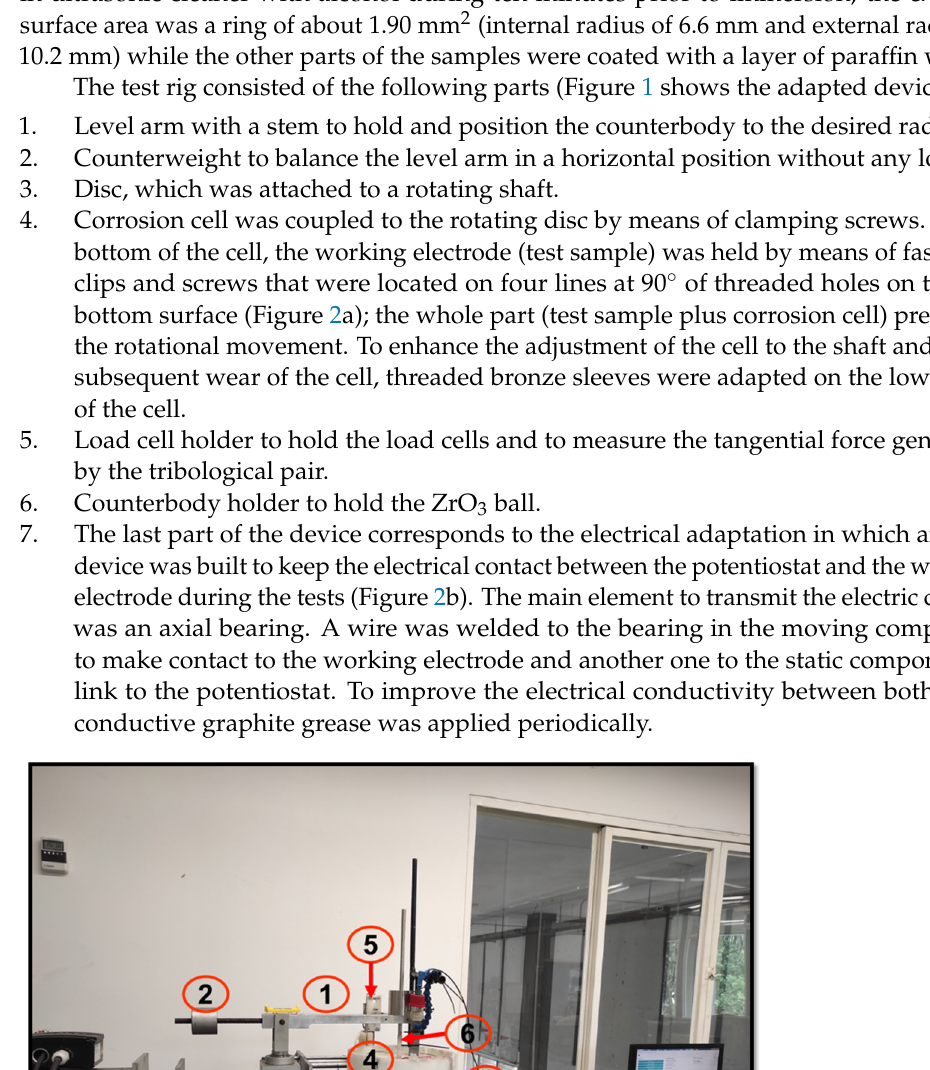
Figure 2. ( a ) Front; ( b ) back of corrosion cell. The storage capacity of the cell is 1.3 L. The corrosion cell, sample and counterbody holders were made with Nylon to ensure electrical insulation. According to the ASTMG119 [30], the synergism, S, between wear and corrosion is described in terms of metal loss due to both mechanical and chemical processes by means of the following Equation (1):